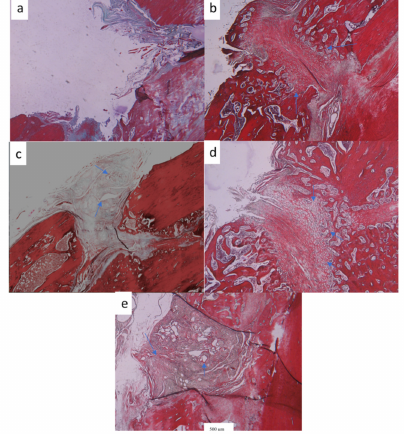
Figure 3. Histopathologic sample of each group. ( a ) Control group sample 4 × magnification, defect still seen. ( b ) Omentum group sample 4 × magnification, defect fully loaded with new cells and scaffold was organized with new bone islands (blue arrows). ( c ) Omentum + mesenchymal stem cell sample 4 × magnification, scaffold still seen with new formed fat cells within scaffold (blue